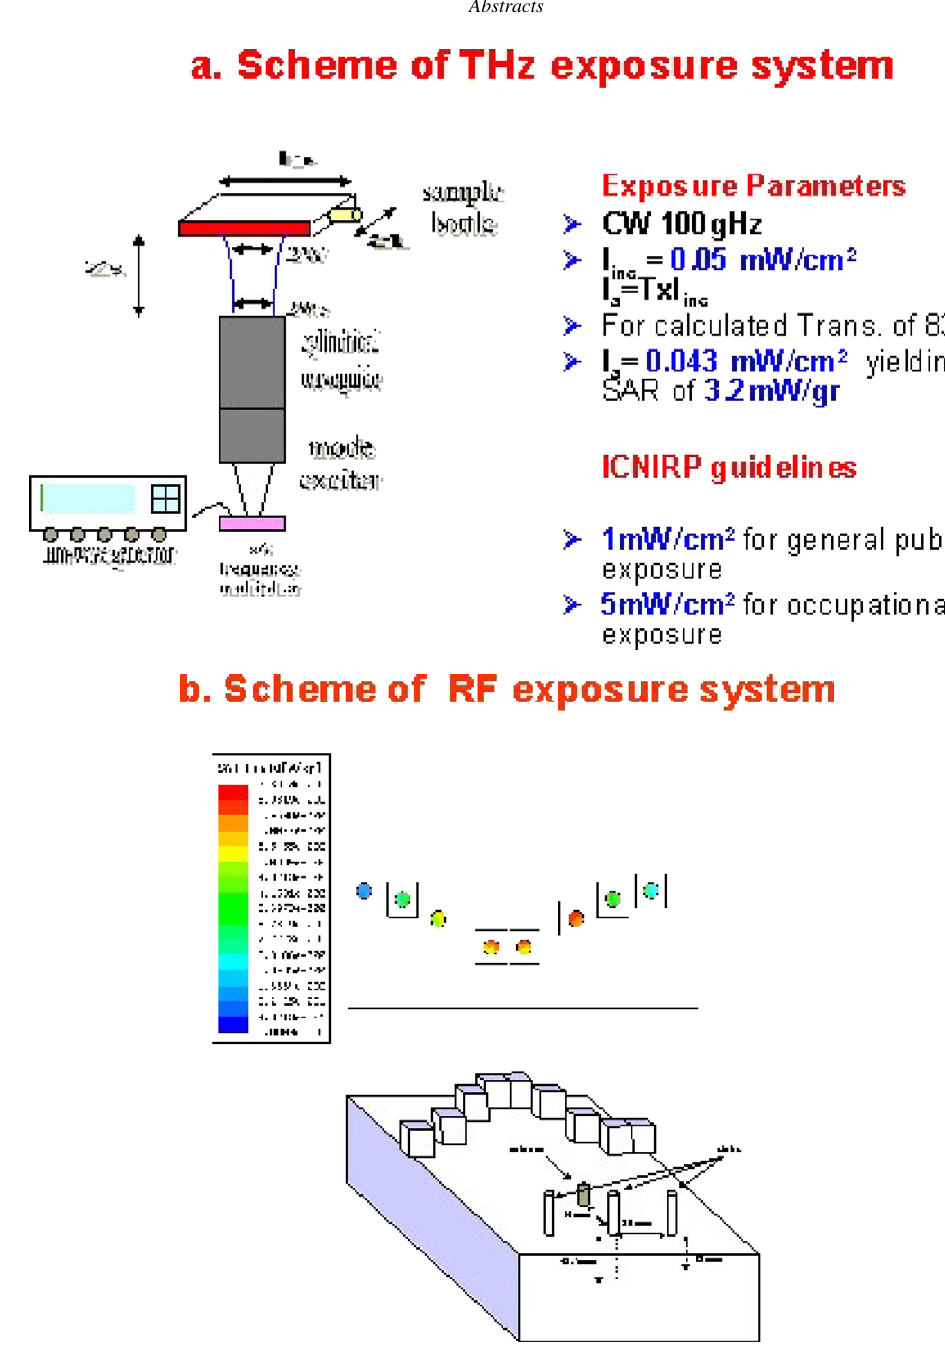
Fig. 2. Schemes of the exposure system used. (a) The exposure system used for the THz frequency and (b) the RF frequency radiation. relationship. The increased asynchronous replication of centromers was found to be correlated with elevated aneuploidy. It may be suggested that coordinated repli- cation of centromers is necessary for the proper func- tion of the segregating machinery. Moreover it seems